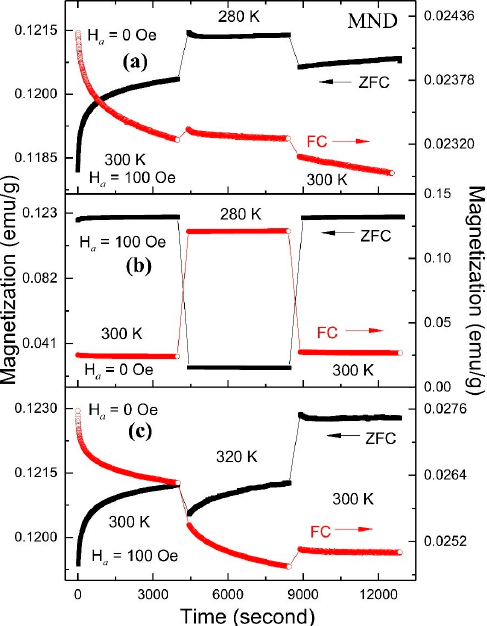
Figure 6. The effect of temperature-cooling ( a ) without, ( b ) with field switching, and ( c ) temperature- heating cycle without field switching during ZFC and FC magnetization relaxation from